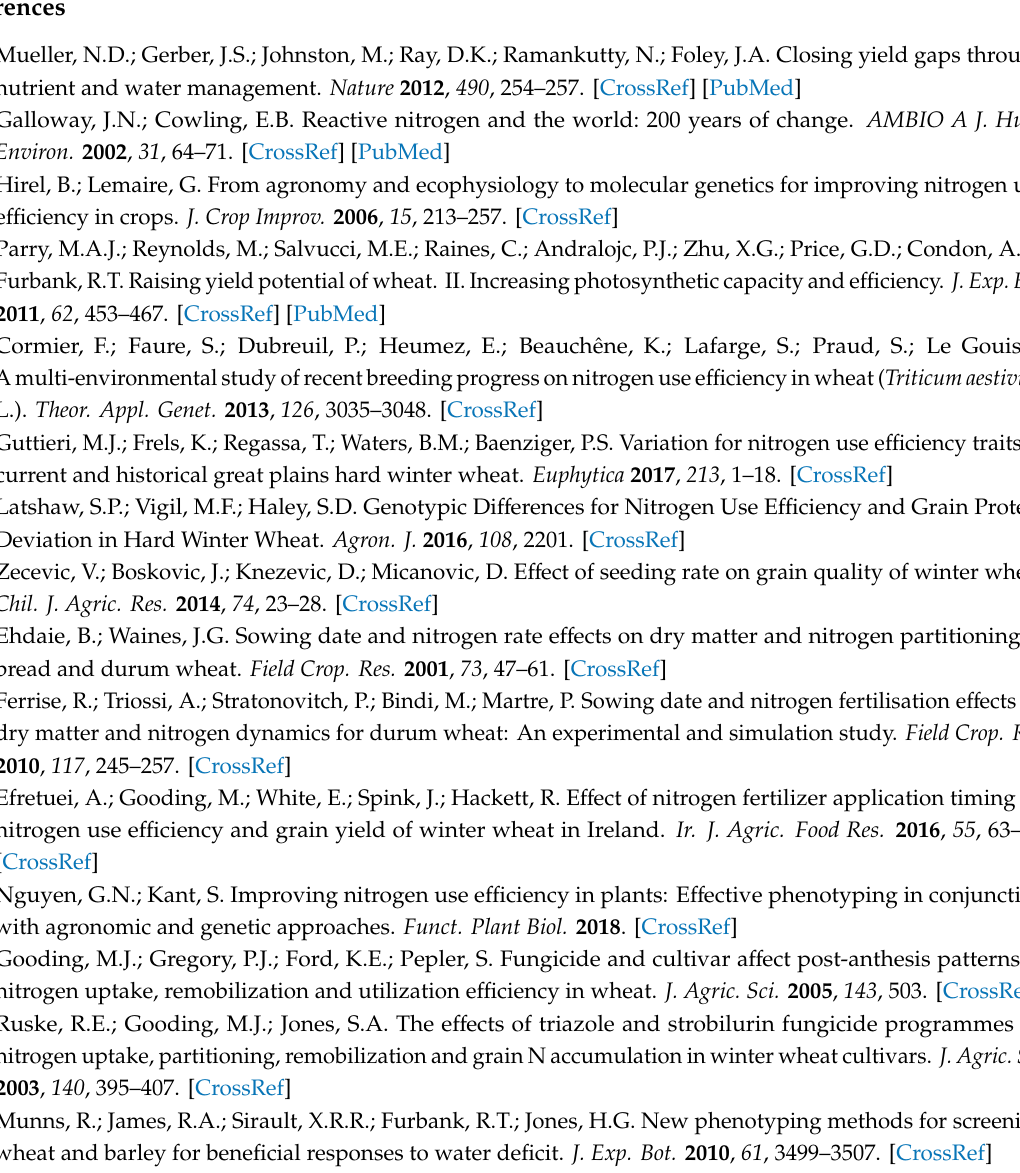
Supplementary Figure S1: Pairwise trait relationships of traits of trait complexes e and f, Supplementary Table S1: ANOVA results for further, Supplementary Table S2: Early development from leaf development to early stem